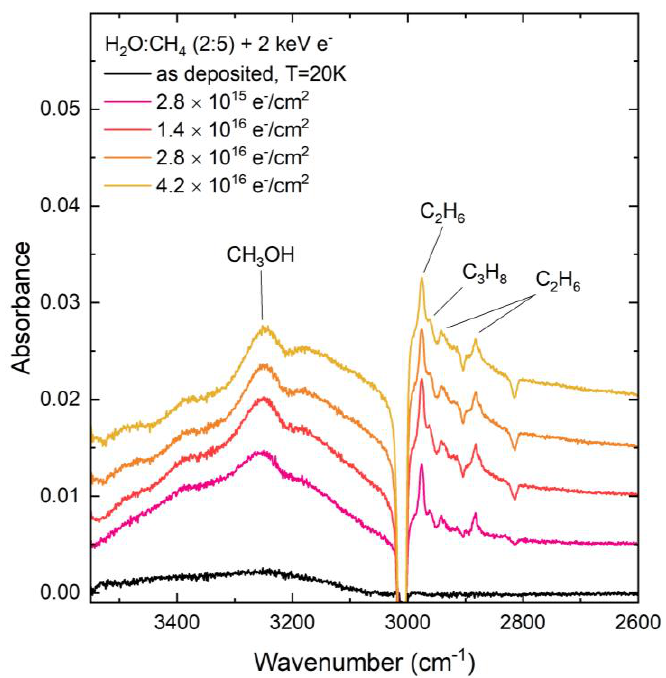
Figure 3. Mid-infrared absorption spectra of a CH 4 :H 2 O (=5:2) mixed ice upon preparation at 20 K and during irradiative processing using 2 keV electrons. Note that spectra acquired during irradiation are so-called ‘difference spectra’ yielded after the subtraction of the ‘as-deposited’ spectrum. The spectra are focused on the 3500–2600 cm − 1 region so as to highlight the formation of CH 3 OH as a result of the electron irradiation of the CH 4 :H 2 O mixed ice.